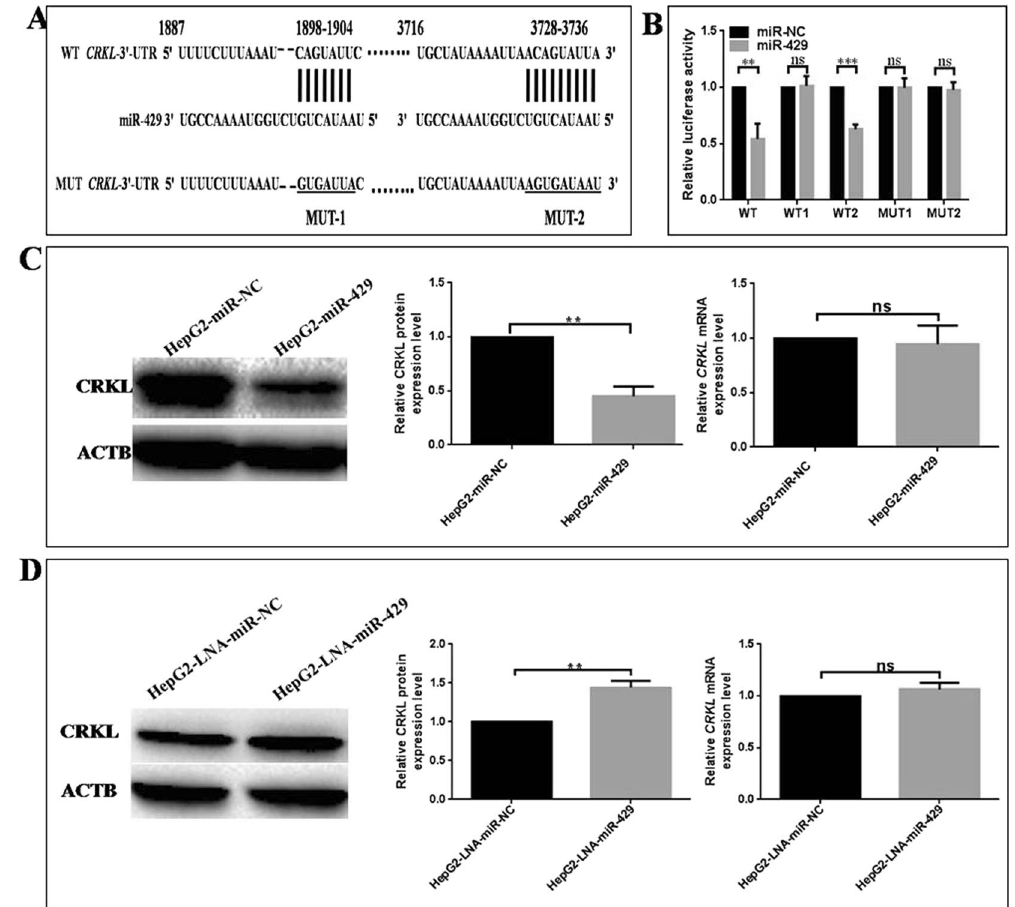
Figure 1. miR-429 translationally regulated CRKL expression by targeting its 3 ′ -UTR selectively. ( A ) Putative binding sites for miR-429 at CRKL -3 ′ -UTR. ( B ) Luciferase activity assay of the interaction between miR-429 and CRKL -3 ′ -UTR. HepG2 cells were co-transfected with miR-429 or miR-NC and psiCHECK-2-CRKL-3 ′ - UTR-WT or psiCHECK-2-CRKL-3 ′ -UTR-MUT for 48 h. Renilla luciferase activity was normalized to Firefly luciferase activity. ** P < 0.01, *** P < 0.001 refer to the differences were significant compared with negative control. ( C , D ) miR-429 negatively regulated endogenous CRKL at protein level rather than at mRNA level. The endogenous CRKL protein and mRNA levels were measured by WB and qRT-PCR in HepG2 cells transfected with miR-429, miR-NC, LNA-miR-429, LNA-miR-NC for 48 and 72 h, respectively. ACTB was used as the internal reference. ** P < 0.01 refers to difference obtained in comparison with the negative